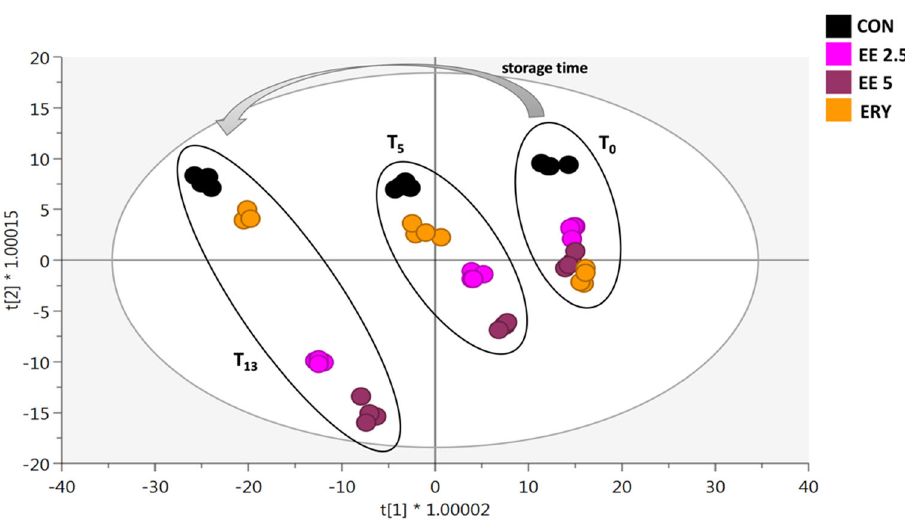
Figure 3 . Orthogonal projections to latent structures discriminant analysis (OPLS ‐ DA) considering Figure 3. Orthogonal projections to latent structures discriminant analysis (OPLS-DA) considering the different beef burgers (CON, EE 2 ‐ 5, EE 5, and ERY) during the entire storage period. the different beef burgers (CON, EE 2-5, EE 5, and ERY) during the entire storage